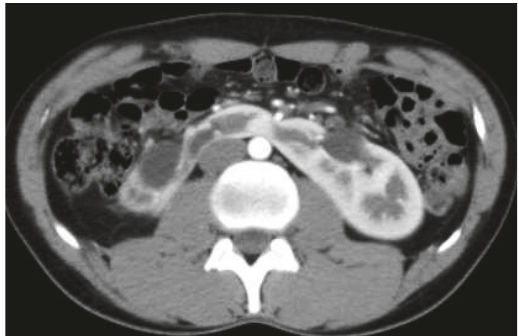
Figure 2: Initial preoperative CE-CT scan (axial section) showing horseshoe kidney with the fusion of the lower poles to the left of aorta.